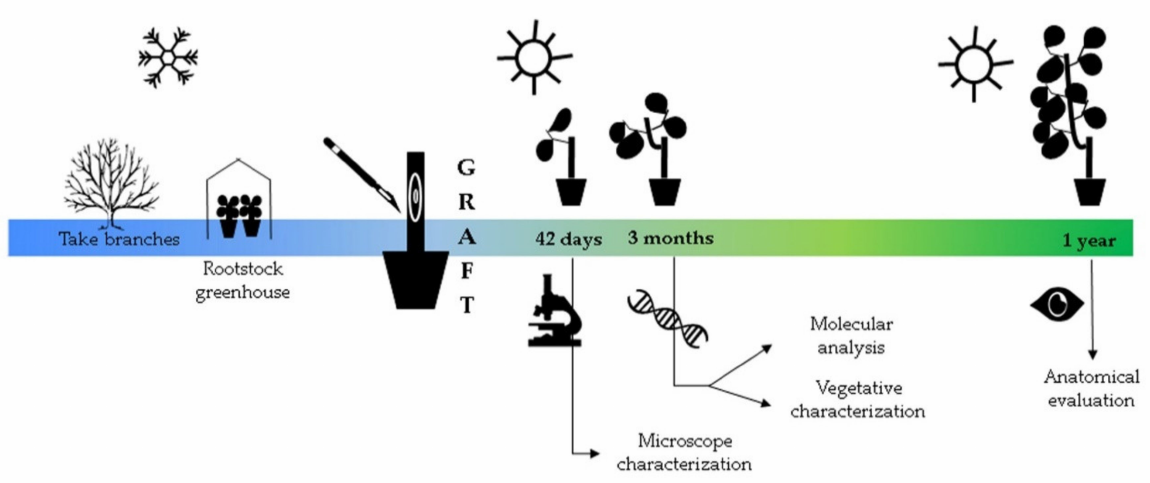
Figure 1. Time line of experimental design to determine graft compatibility during one